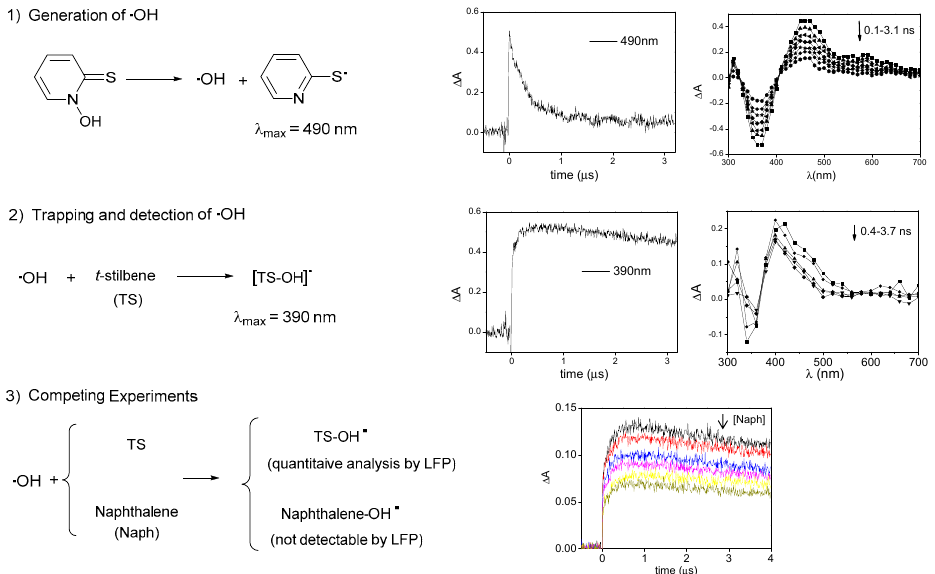
Scheme 1. Experimental generation of the hydroxyl radical, trapping with trans -stilbene and competitive analysis in the presence of